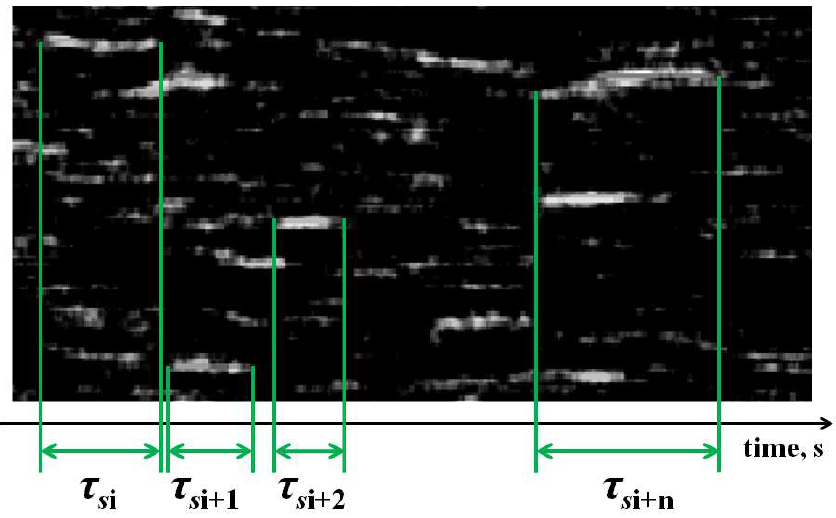
Figure 4. An image of a SSH map fragment illustrating a method for estimating speckle lifetimes.